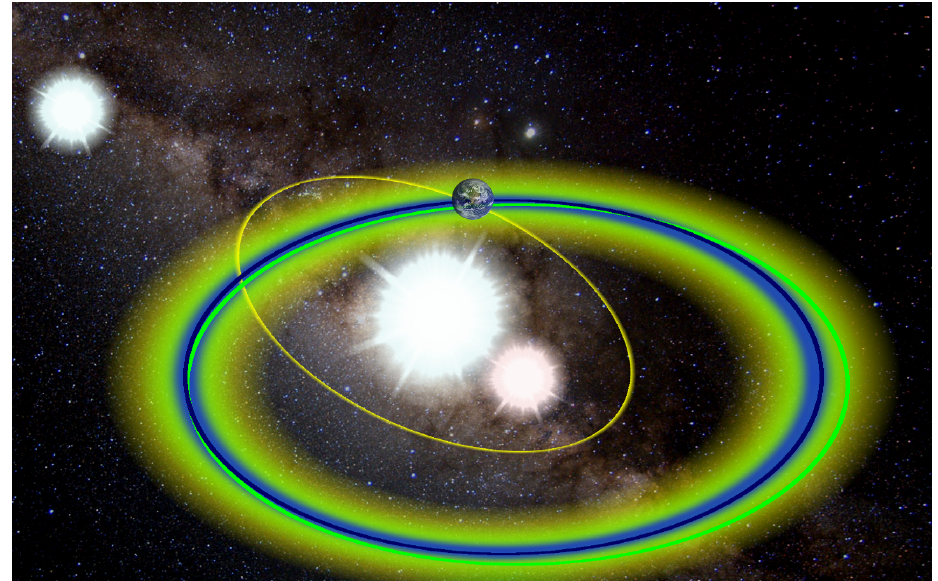
Figure 7. Dynamically informed habitable zones. The permanently habitable zone in blue represents the most conservative limits. A planet started in the permanently habitable zone will never exceed habitable insolation limits throughout its orbital evolution. In contrast, a planet in the averaged habitable zone (yellow) can experience ample excursions beyond habitable insolation limits as long as the insolation average permits liquid water near the surface of the planet. The green curve represents an orbit of the extended habitable zone as defined in